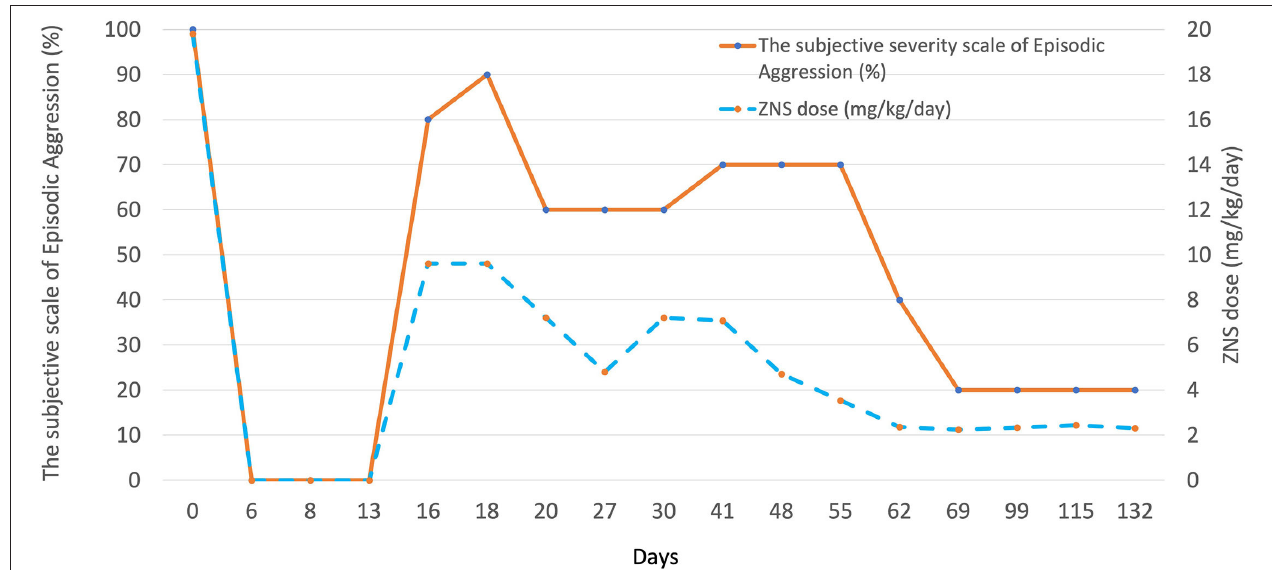
FIGURE 1 | A graph illustrating the association between the dose of ZNS and the severity of episodic aggression in case 2. Multiple dose adjustments resulted in significant changes in the severity of the abnormal behavior episodes in this case. The severity of episodic aggression was determined based on the client’s oral description at each follow-up; 100% at the initial